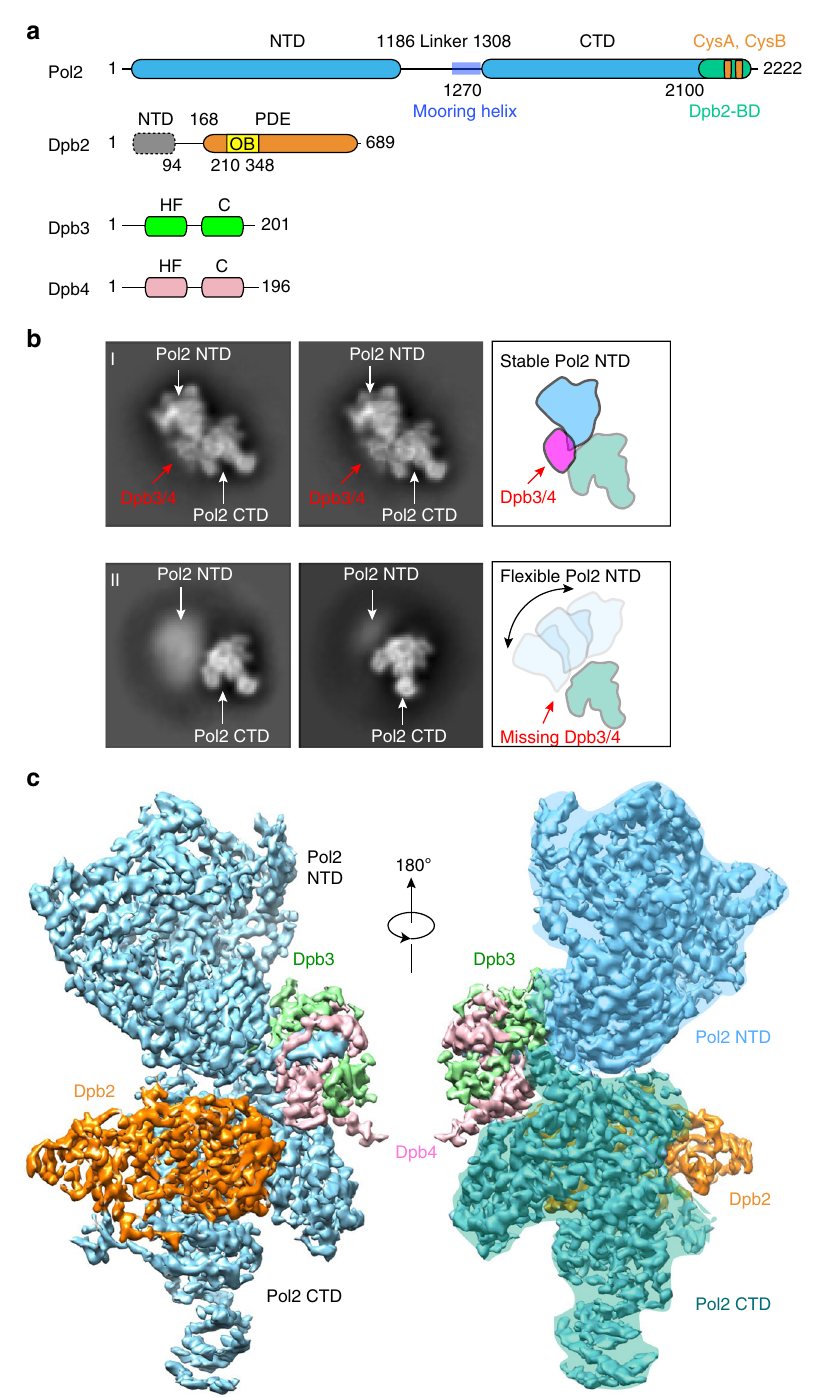
Fig. 1 Cryo-EM structure of the S. cerevisiae leading strand Pol ε . a Domain architecture of the four subunits of the holoenzyme: Pol2 contains two polymerase domains, the catalytic NTD and the non-catalytic CTD. There is a Dpb2-binding domain (Dpb2-BD) in the CTD that further contains two Cys motifs (CysA and CysB). Dbp2 has an OB domain and a calcineurin-like PDE domain. Dpb3 and Dbp4 each contain a histone fold domain (HF) and a C- terminal region (C). b 2D class averages of Pol ε showing the rigid state (I) and fl exible state (II). c 3D map in front and back views, with each subunit shown in a distinct